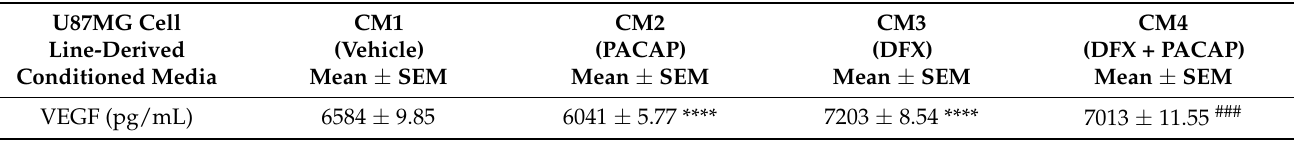
Table 1. VEGF content in conditioned medium from U87MG cells. VEGF levels were detected in supernatants and ex- pressed in pg/mL. Data resulting from three independent experiments are represented as means ± SEM. **** p < 0.0001 vs. CTRL; ### p < 0.001 vs. DFX.